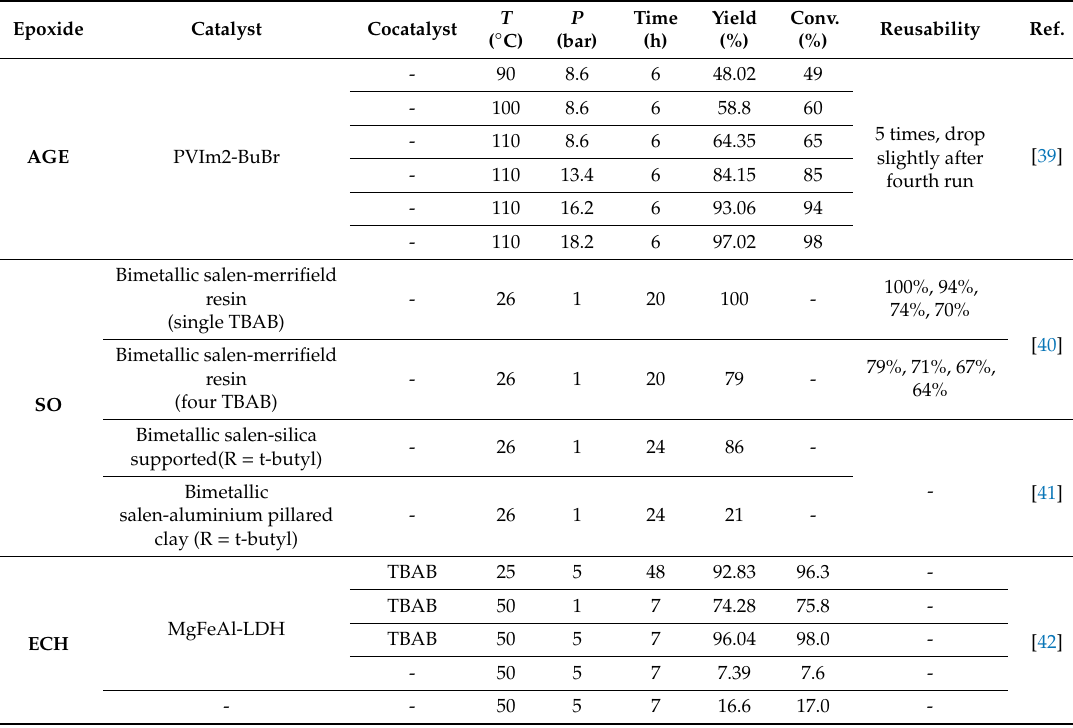
Table 2. Supported catalysts for cycloaddition of CO 2 to